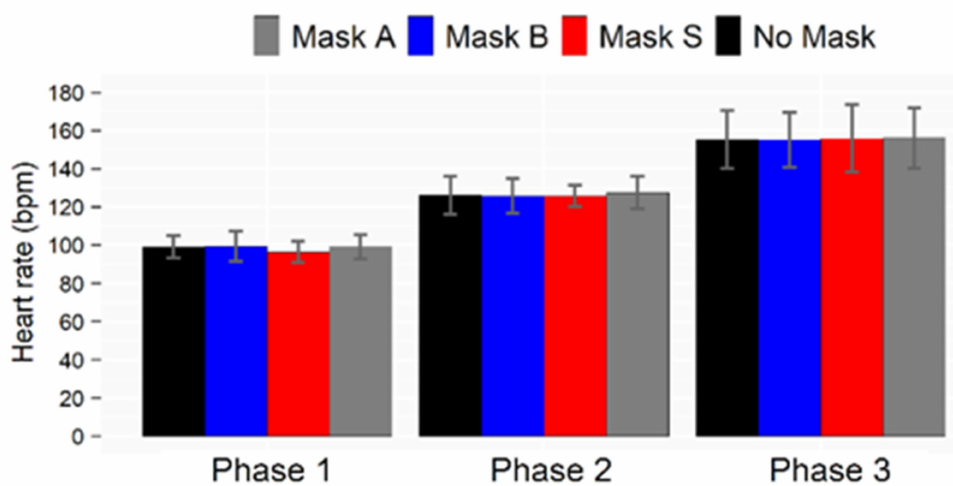
Figure 10. Heart rates measured during the physical activity phases and reported as averages across testers. Error bars refer to the standard deviations.